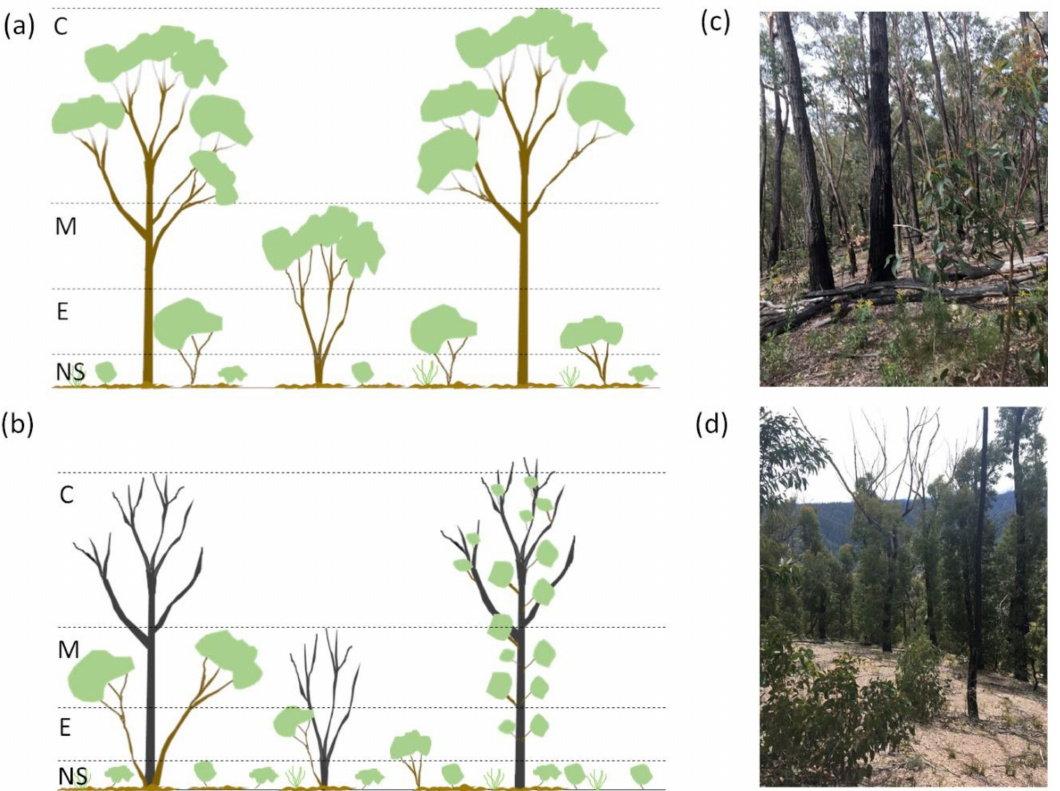
Figure 2. Graphic depiction of the fuel layers measured in the study. The panels show the delineation of the fuel strata for open forests that are either ( a ) long unburnt or recently burnt by understorey fire and ( b ) recently burnt (i.e., ≈ 6 years post-fire) by canopy fire. Photos ( c , d ) were taken six years following an understorey fire and a canopy fire, respectively. The fuel type depicted in panel ( a ) corresponds to the photo in panel ( c ) and the fuel type in panel ( b ) corresponds to the photo in panel ( d ). The broken horizontal lines show the boundaries between fuel strata. The fuel strata are near-surface (NS), which includes grasses and small shrubs (typically <50 cm tall); elevated (E), which includes medium-sized shrubs and tree saplings (typically 50–200 cm tall); mid-storey (M), which includes tall shrubs and subcanopy trees (typically >200 cm); canopy (C), which is the uppermost tree stratum. Plants were assigned to the strata that encompassed most of their foliage. For example, the tree that is resprouting from the trunk and branches in panel ( b ) would be assigned to the canopy stratum, whereas the tree resprouting from the base would be assigned to the mid-storey